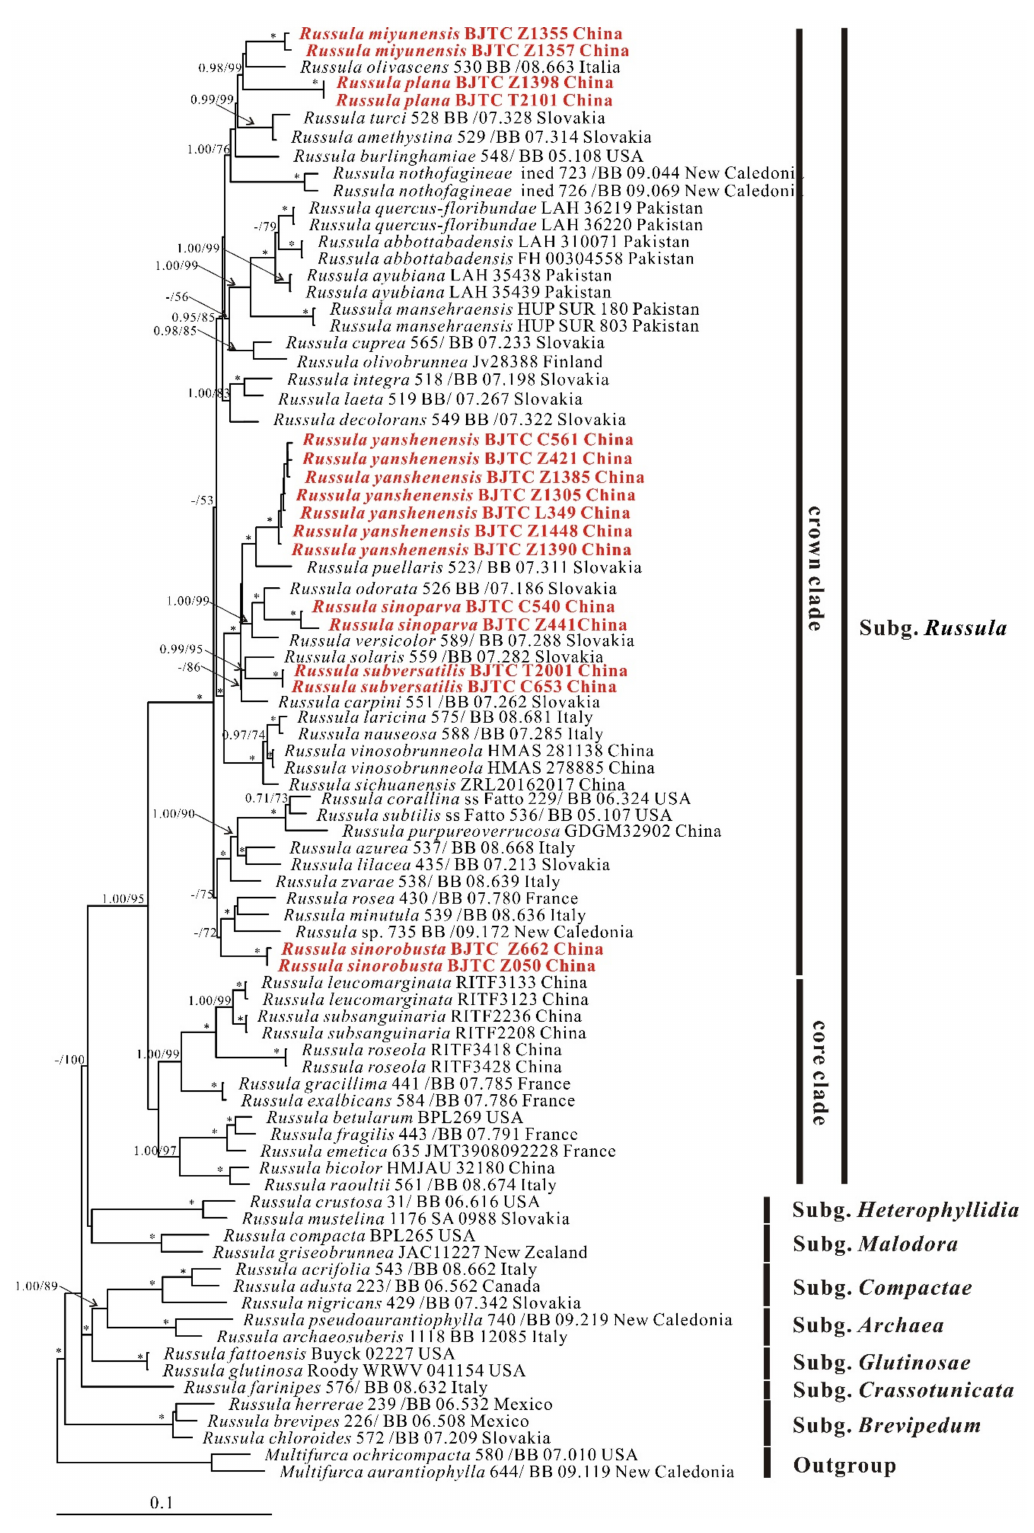
Figure 2. The nrLSU- rpb2 - tef-1 α -mtSSU multi-locus phylogenetic tree obtained from the Bayesian analysis. Numbers above branches represent strongly and moderately support (pp ≥ 0.95 and/or MLB ≥ 50%). Numbers above branches are Bayesian posterior probability (pp) values and maximum likelihood bootstrap (MLB). The red font indicates the position of newly obtained sequences. Acces- sion numbers of sequences information used are indicated in Table 1. Asterisks (*) denote branches with pp = 1.00, MLb =